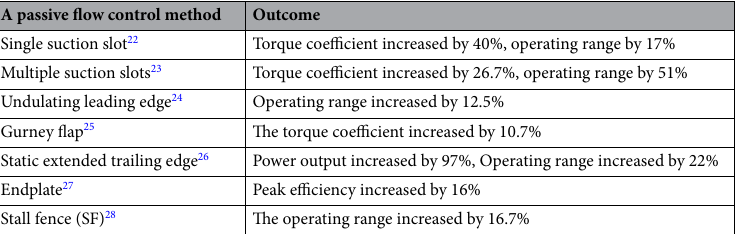
Table 1. Wells turbine modification using passive flow